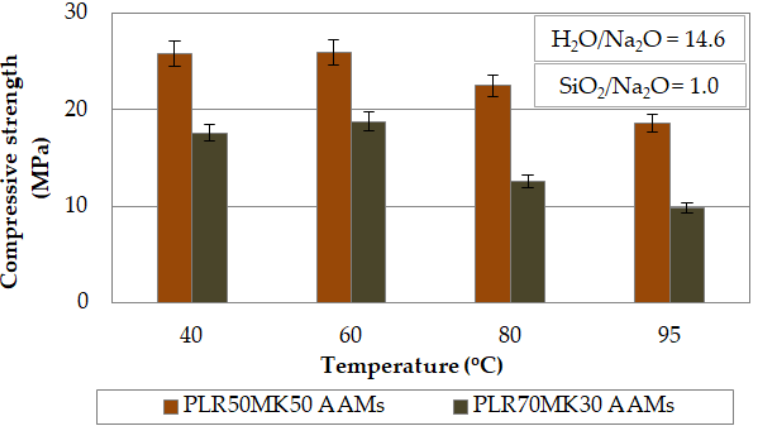
Figure 2. Effect of curing temperature on the compressive strengths of PLR50MK50 and PLR70MK30 AAMs (pre-curing time 4 h, curing time 24 h, ageing period 7 days; error bars indicate the standard deviation of measurements obtained from three specimens).